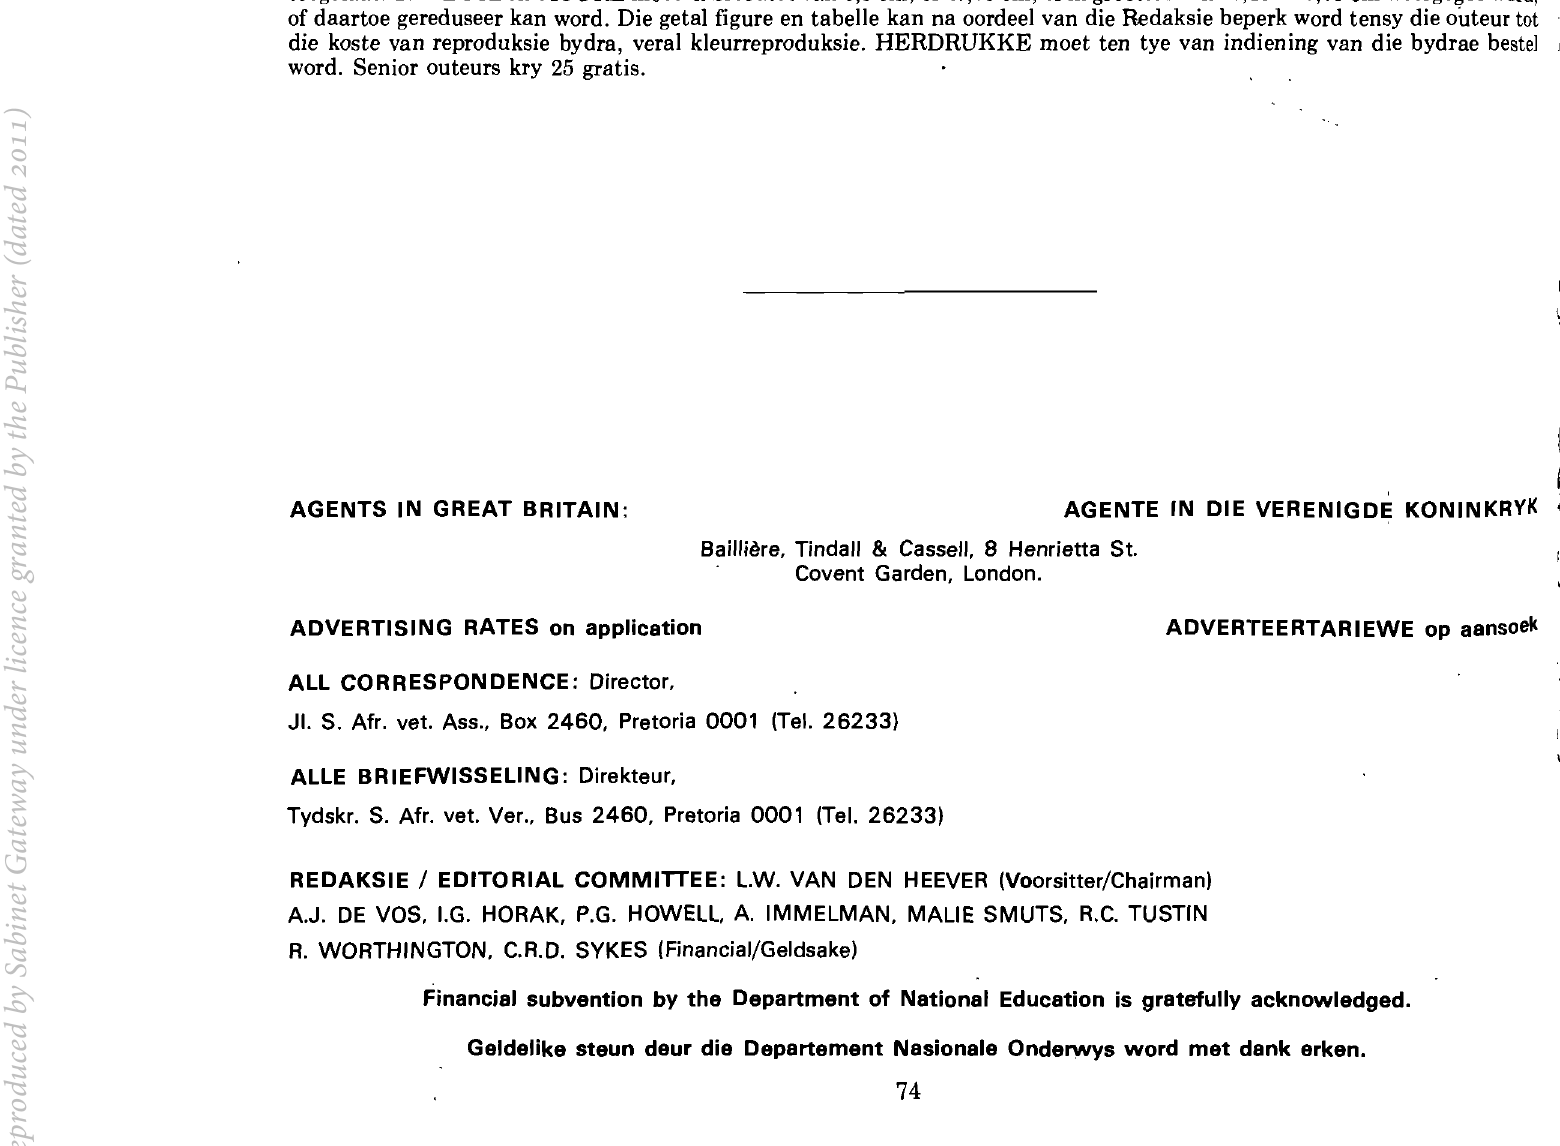
TYDSKRIF VAN DIE SUID-AFRIKAANSE VETERINERE VERENIGING Die TYDSKRIF is die offisiele mondstuk en eiendom van en word gepubliseer deur die Suid-Afrikaanse Veterinere Vereniging. Dit verskyn kwartaalliks en word aan sake van algemene veeartsenykundige belang gewy. Bydraers tot hierdie Tydskrif maak hul stellings en lug hul menings slegs op eie verantwoordelikheid; sodanige steIIings word nie noodwendig deur die Redaksiekomitee onderskryf nie en die menings gee nie noodwendig die Komitee se menings weer nie. Kopeireg word op al die letterkundige inhoud van die Tydskrif voorbehou. ,. BYDRAES - Die Redaksie sal aIle bydraes van veeartsenykundige belang vir publikasie oorweeg. Dubbel-gespasieerde, noukeurig hersiende, getikte manuskripte moet in triplikaat (oorspronklike en twee afskrifte) ingedien word, Opset en verwys ing moet die styl van hierdie uitgawe volg. MEER AS 20 VERWYSINGS word slegs met die goedkkeuring van die Redakteur toegelaat. TABELLE en FIGURE moet in breedtes van 8,5 cm, of 17,75 cm, of in groottes van 26,25 x 17,75 cm weergegee word, of daartoe gereduseer kan word. Die getal figure en tabelle kan na oordeel van die Redaksie beperk word tensy die outeur tot die koste van reproduksie bydra, veral kleurreproduksie. HERDRUKKE moet ten tye van indiening van die bydrae bestel I word. Senior outeurs kry 25